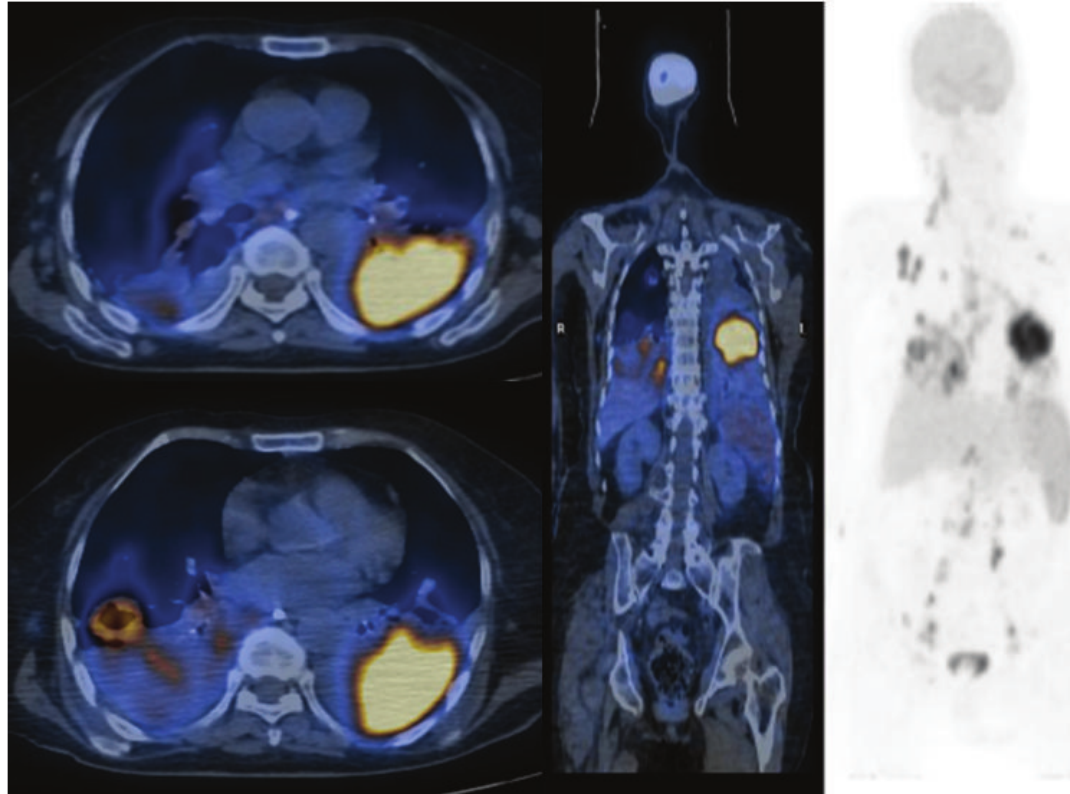
Figure 4: PET/CT scan showing increased 18F-FDG uptake multicompartmental lymphadenopathies and lung lesions.